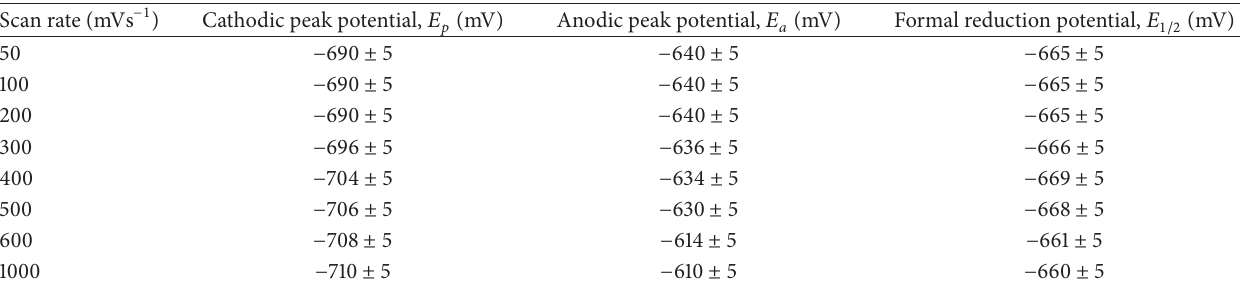
Table 1: Variation of peak potentials and formal reduction potential with scan rate for the reduction of doxorubicin hydrochloride in aqueous buffer at pH 7.4 on glassy carbon electrode. [Doxorubicin hydrochloride] = 33 𝜇 M, [Hepes buffer] = 15mM, and [NaCl] = 160mM and temperature = 25 ∘ C.